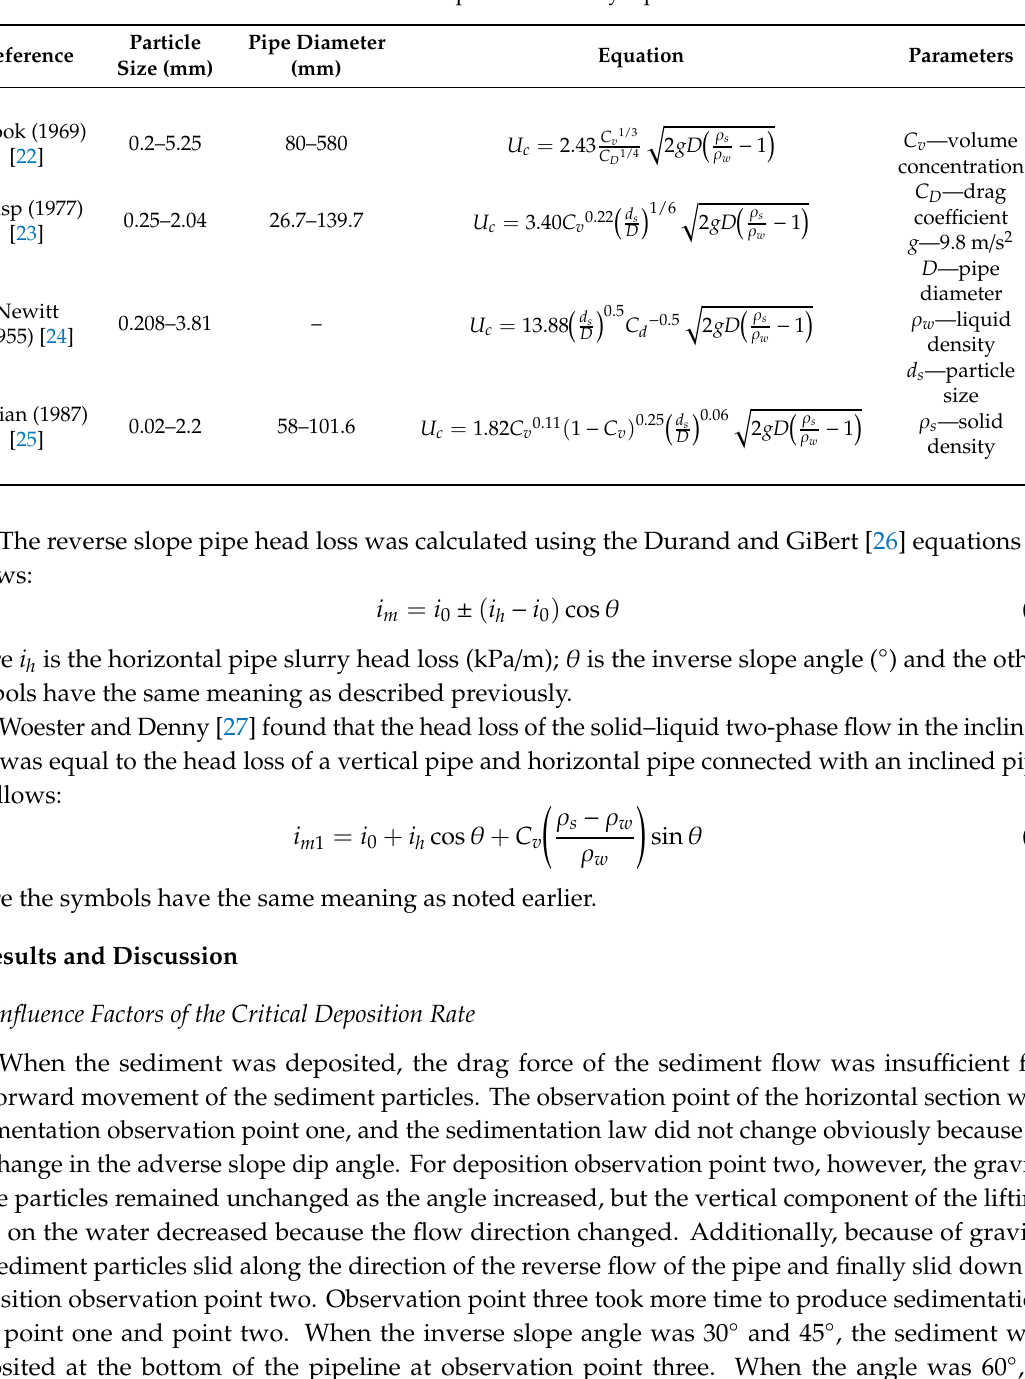
Table 3. Critical deposition velocity